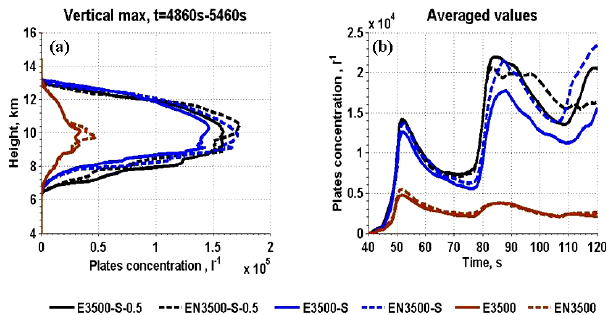
Figure 5. Vertical profiles of (a) maximum values of plate concen- tration and (b) time dependencies of averaged plate concentration. The profiles are obtained by averaging over the time period of 4860– 5460s. The low and the upper arrows in panel (b) show approximate contribution of the smallest CCN and the additional CCN activated in NA,